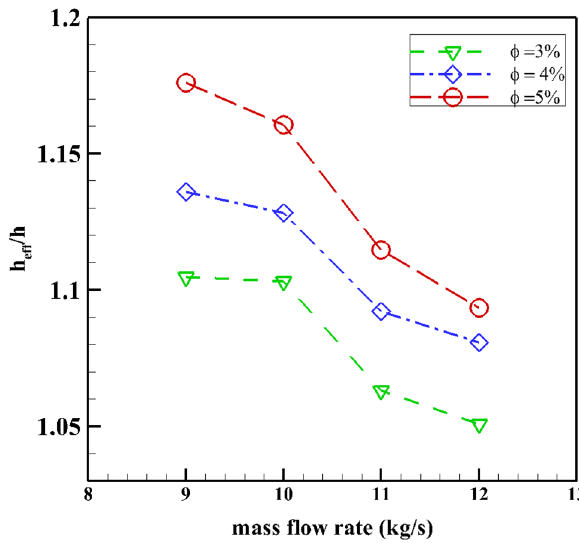
Fig. 20 Convective heat transfer coefficient ratio at constant con- centration vs flow rate